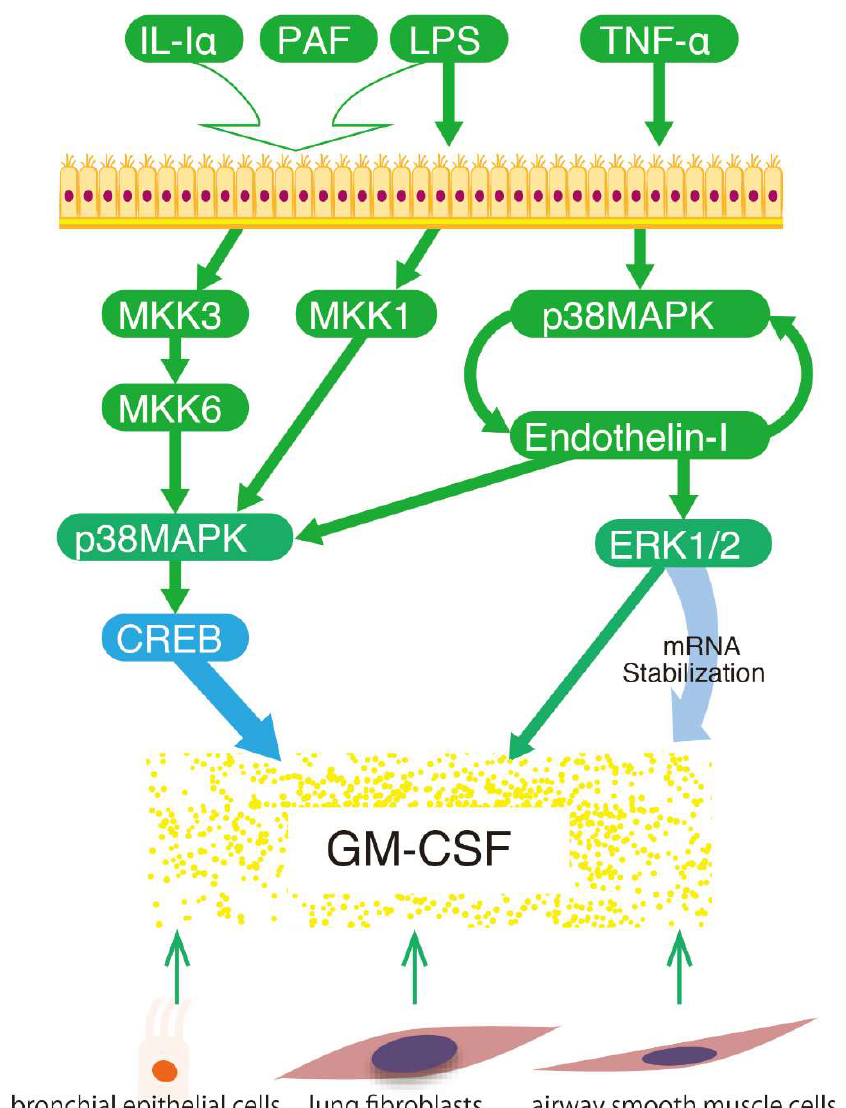
Figure 4. ERK1/2 and p38 MAPK-CREB-mediated GM-CSF secretion. IL-1α, PAF, LPS and TNF-α induce p38 MAPK and CREB phosphorylation. Remarkably, TNF-α induced p38 MAPK activation has a positive feedback loop mediated by endothelin-1 and facilitates both p38 MAPK and ERK1/2 activation following GM-CSF secretion and mRNA stabilization.